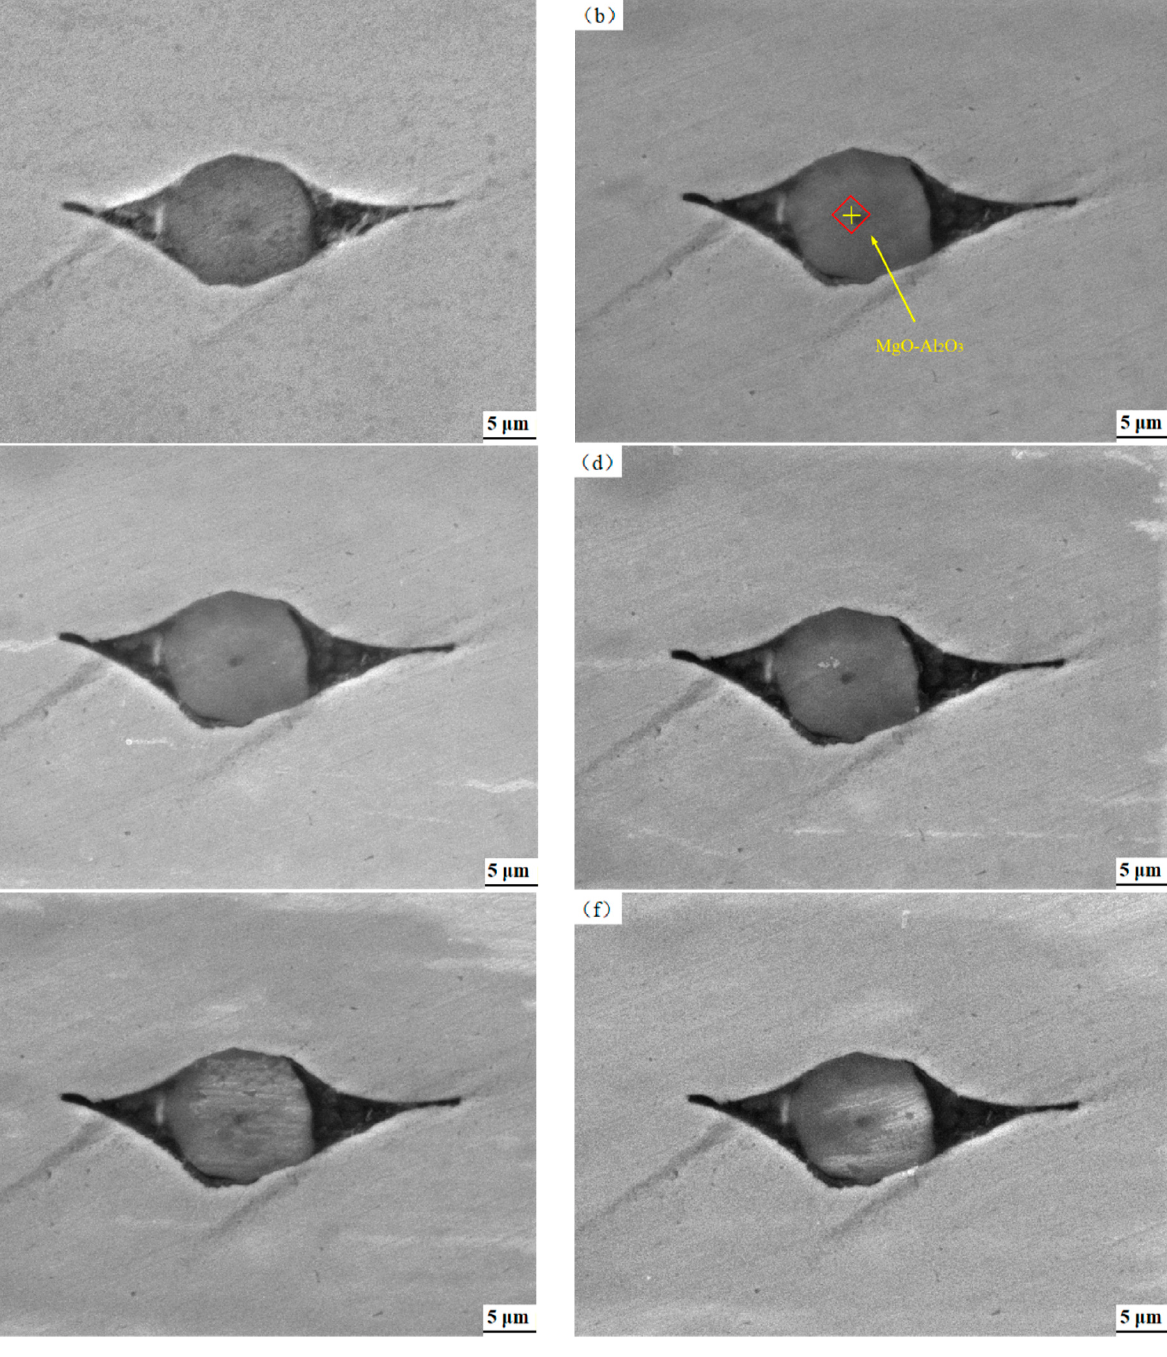
Figure 2. Inclusion morphologies with different acidification durations: ( a ) 0 s; ( b ) 30 s; ( c ) 50 s; ( d ) 70 s; ( e ) 90 s; and ( f ) 110 s.